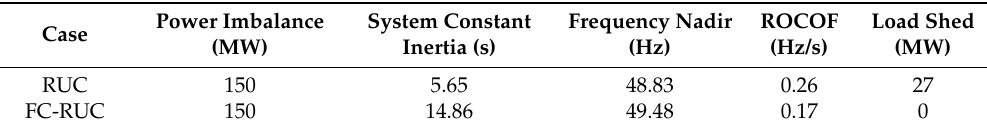
Table 5. Summary of Contingency 1 at Hour 7.